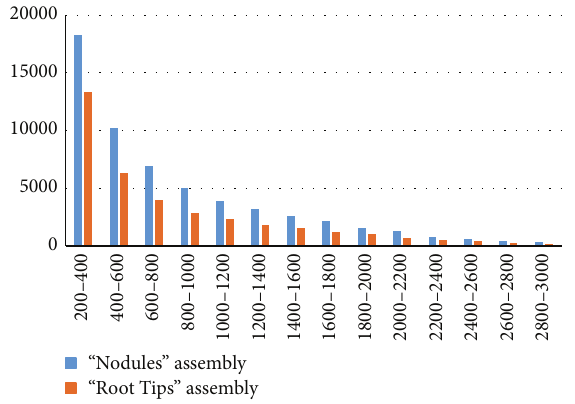
Figure 1: Length distribution of contigs obtained from “Nodules” and “Root Tips” assemblies.